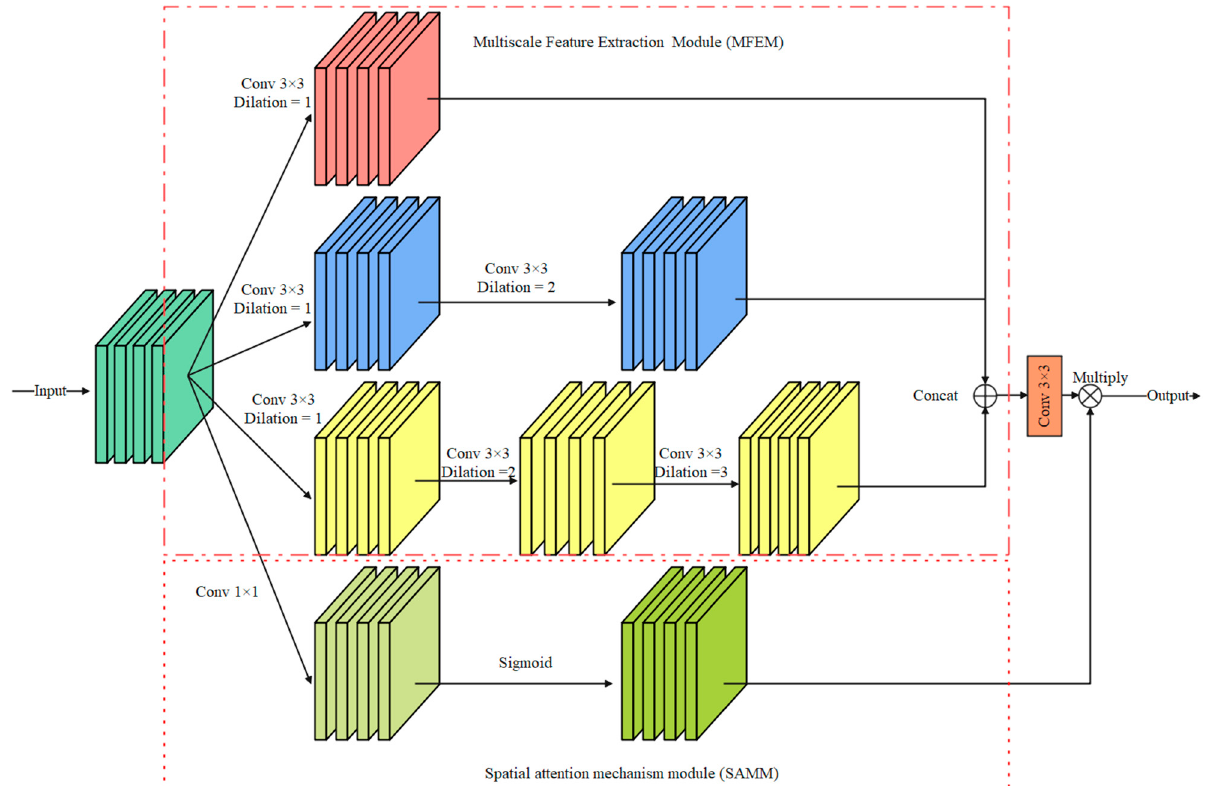
Figure 5. Multiscale feature information extraction module